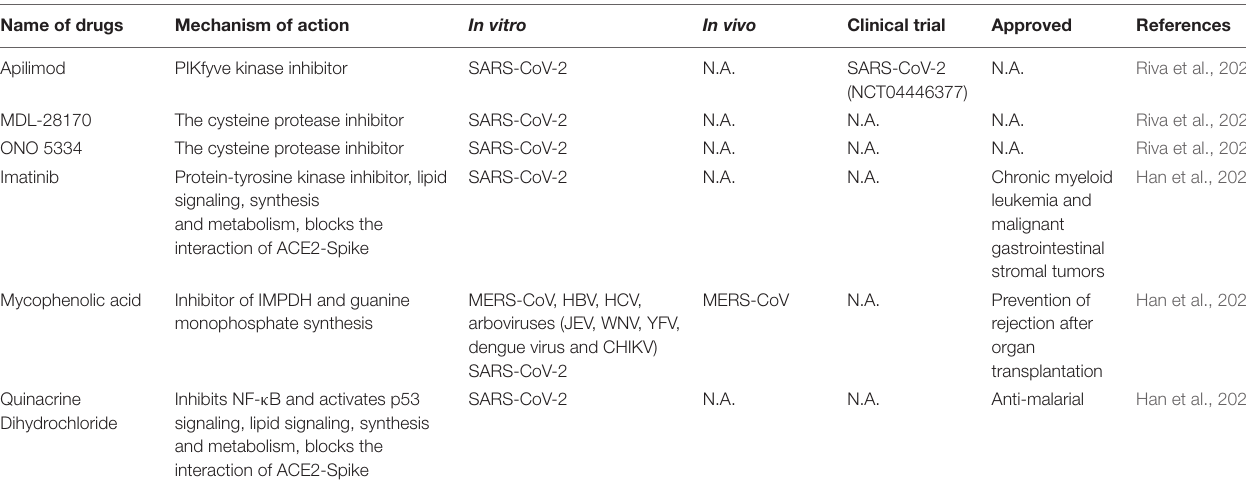
TABLE 3 | Representative high throughputing screened strategies for CoV